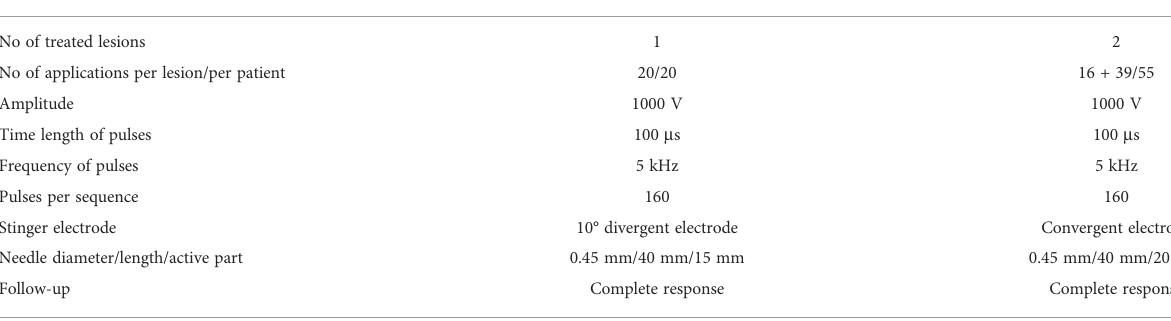
TABLE 1 Patients, procedures, electrodes and response to the